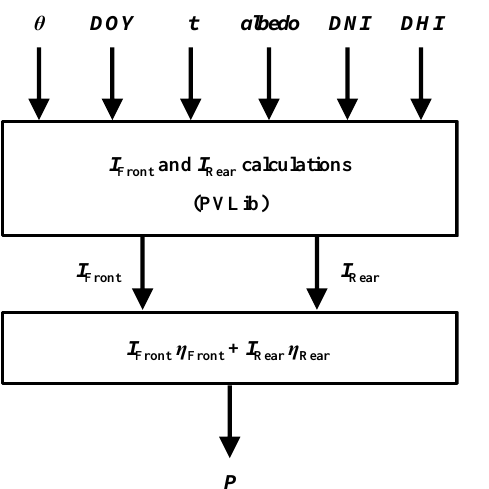
Figure 1. Diagram of virtual 1-axis tracking bifacial photovoltaic (BPV) array.